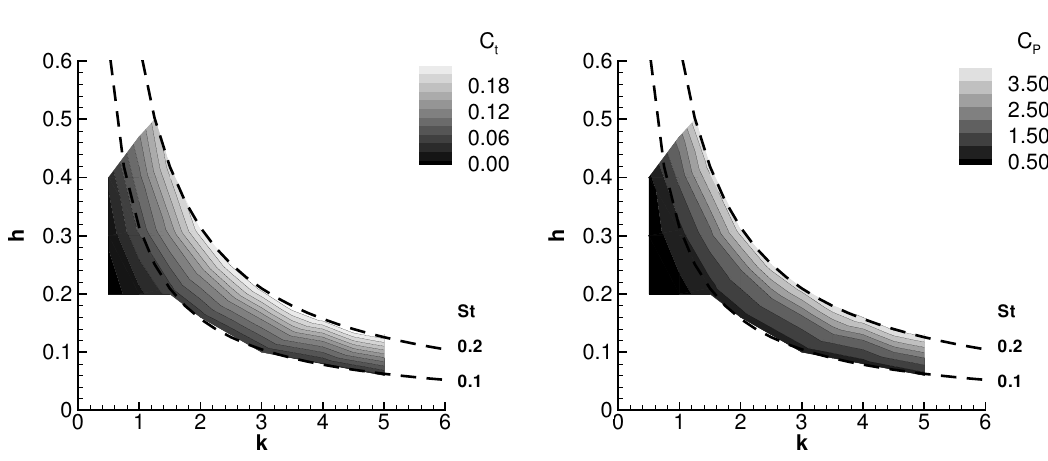
Figure 11. Mean thrust and power coefficients with Re = 34,000.